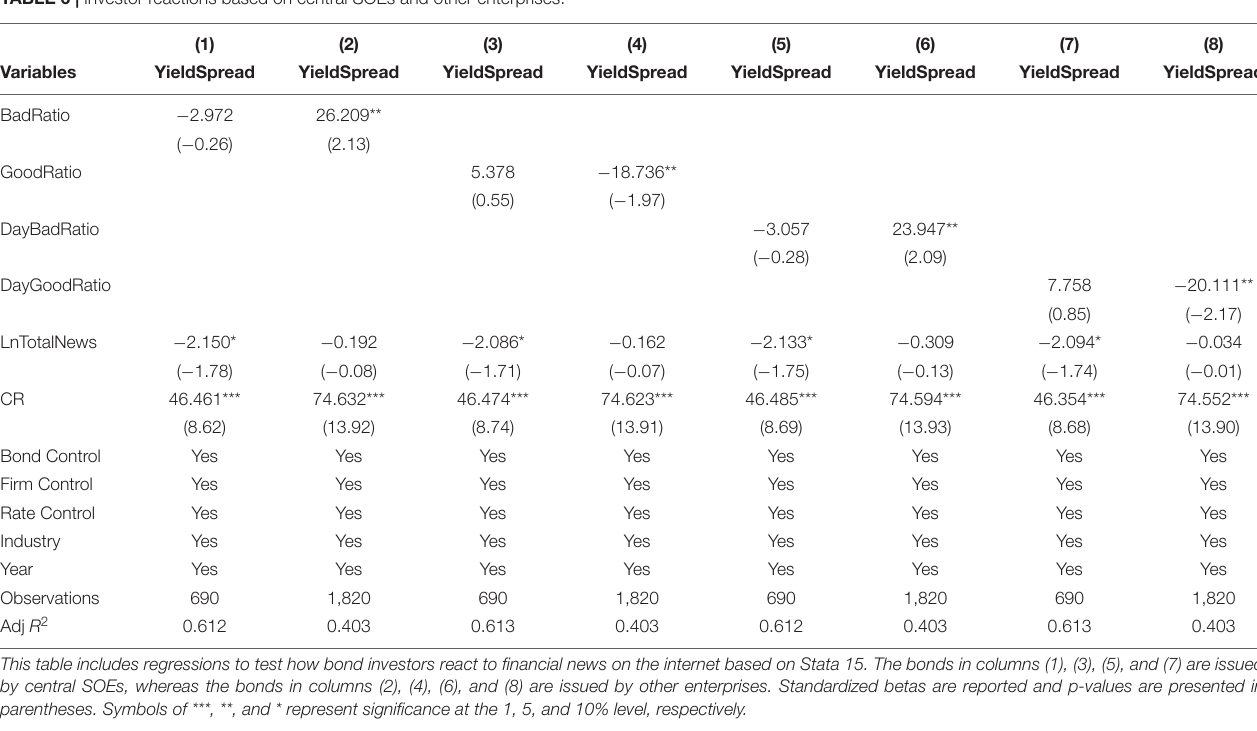
TABLE 6 | Investor reactions based on central SOEs and other enterprises.